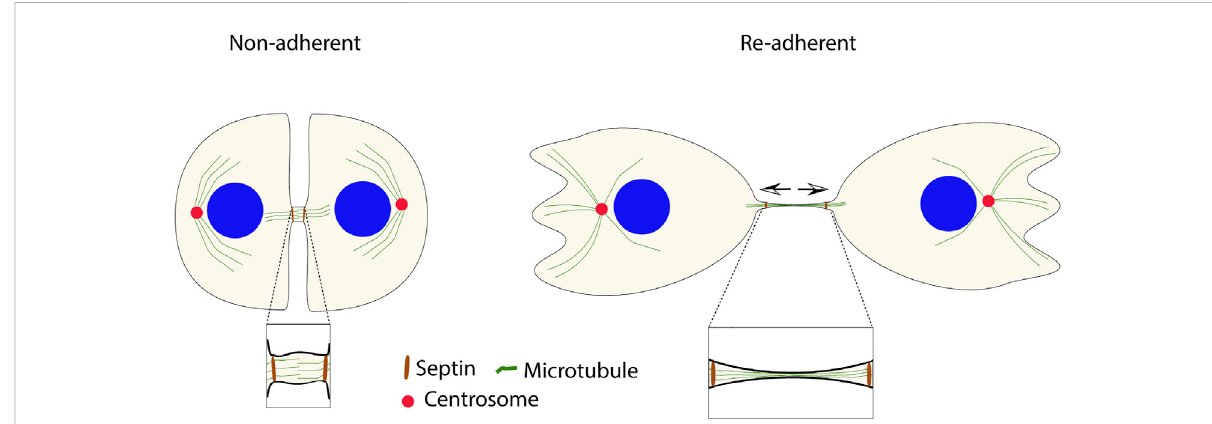
FIGURE 3 Cyto fi ssion is an alternative mechanism to ful fi ll the incomplete cytokinesis in non-adherent cells after re-adhesion. MB-independent fi ssion can occur due to the stability of the furrow by septin fi laments (in brown). The arrows show the direction of tension in the connecting